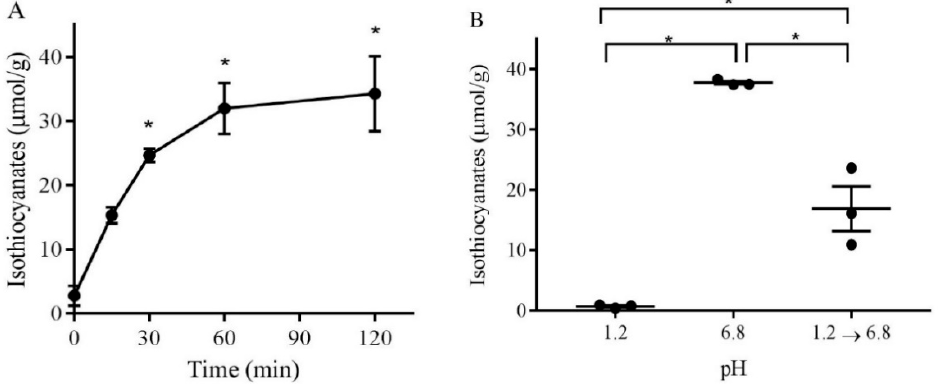
Figure 2. Generation of isothiocyanates from broccoli sprout powder under neutral and acidic pH. ( A ) Broccoli sprout powder was incubated with pH 6.8 buffer at 37 °C. Aliquots were removed at the indicated time points, derivatised using the cyclocondensation assay, and quantified using HPLC with UV detection. Significant formation was detected at 0.5–2 h ( p ≤ 0.05, one way repeated-measures analysis of variance with Dunnett’s multiple comparison test). ( B ) Broccoli sprout powder was mixed with the required solutions (pH 1.2 or pH 6.8) for 1 h. The incubation of broccoli sprout powder at pH 1.2 for 1 h then changing the pH to 6.8 by adding 0.2 M phosphate buffer (pH 1.2 → pH 6.8) for another hour showed a significant reduction of isothiocyanates. Results are mean ± SEM, n = 3 (* p ≤ 0.05, two-tailed Students t -test).